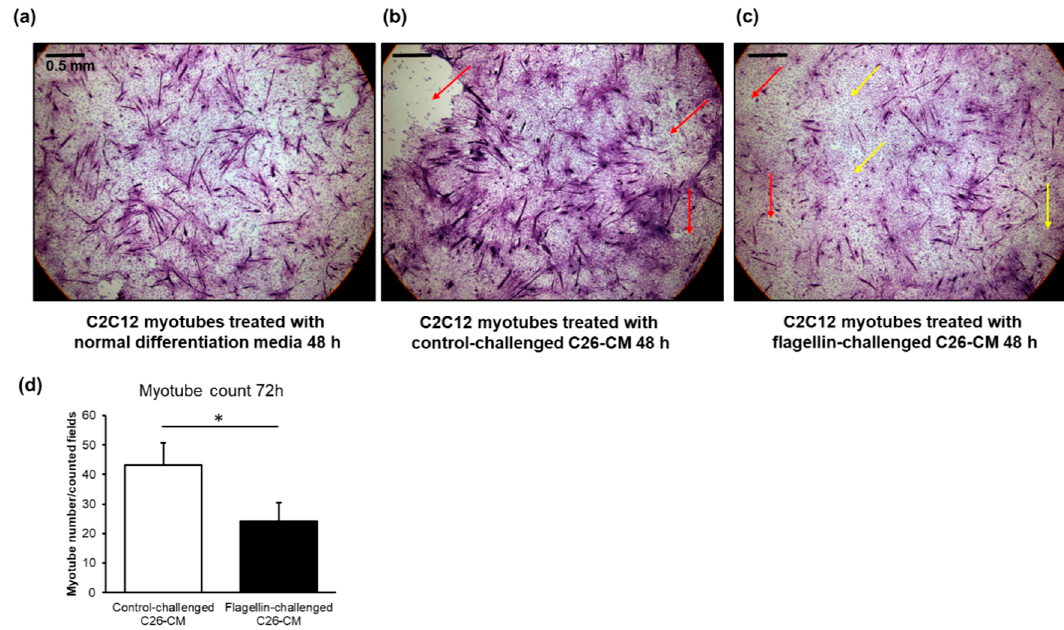
Figure 8. ( a ) Compared to the C2C12 murine myotubes growing in normal differentiation media and ( b ) conditioned media of the C26 cells with control challenge, ( c ) the conditioned media of the flagellin-challenged C26 cells deteriorated and dedifferentiated the multinucleated myotubes into mononucleated myoblasts after 48 h of exposure. The images are hematoxylin & eosin stainings at 4× magnification. The scale bar is 0.5 mm. Red arrows point to the field where myotubes are detached. Yellow arrows point to areas where the myotubes are dedifferentiated. ( d ) Compared to the exposure with the conditioned media of vehicle-treated C26 cells (control), the media of flagellin-treated cells decreased the number of C2C12 myotubes after 72 h of exposure. The scoring of myotubes vs. dedifferentiated myoblasts was based on whether they were multinucleated or mononucleated, respectively. The number of myotubes in each coverslip was counted manually using three to five (depending on the extent of detachment of myotubes) random fields that with 4× magnification, which practically covered the entire coverslip. CM = conditioned media. * Denotes statistically significant difference.